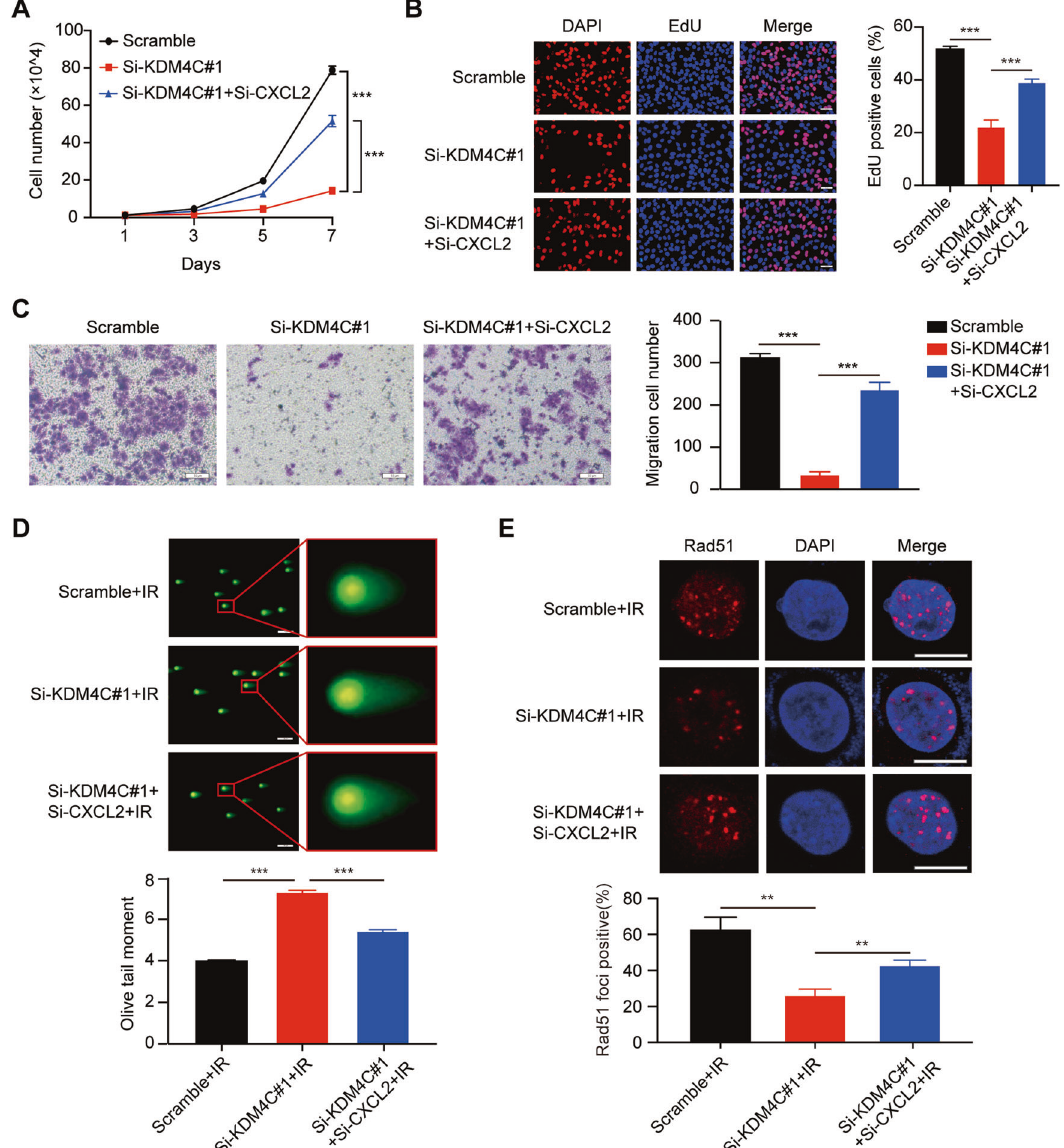
Fig. 8 KDM4C exerts its biological effects by regulating CXCL2 expression in Huh7 cells. A Huh7 cells were transfected with the indicated siRNAs, seeded in six-well plates and counted every other day ( n = 3). B Cell proliferation was examined by an EdU assay ( n = 3). Scale bar, 50 μ m. C Transwell assays were performed to evaluate the migration of Huh7 cells ( n = 3). Scale bar, 50 μ m. D A neutral comet assay was conducted in Huh7 cells to assess single-cell post-irradiation DNA damage in each group ( n = 3). Scale bar, 50 μ m. E Rad51 foci formation was used to analyze DNA repair. Representative immuno fl uorescence images and statistical diagrams are shown ( n = 3). Scale bar, 10 μ